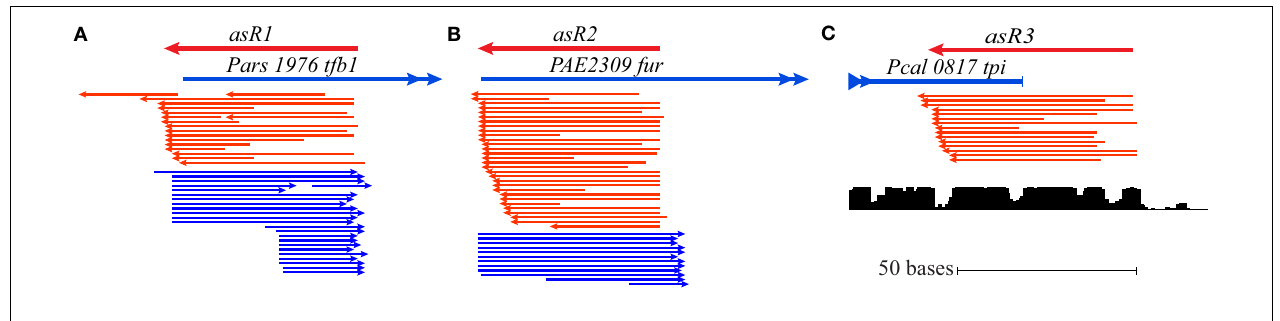
conserved promoters, P u and P d . (B) The antisense sRNA ( asR2 ) gene is defined over the region of antisense-oriented reads that map to the 5 (cid:48) the 3 (cid:48) end of the triose-phosphate isomerase ( tpi ) locus (Pcal_0817 from Pyrobaculum calidifontis ). Sequence conservation [lower graphic (C) ]